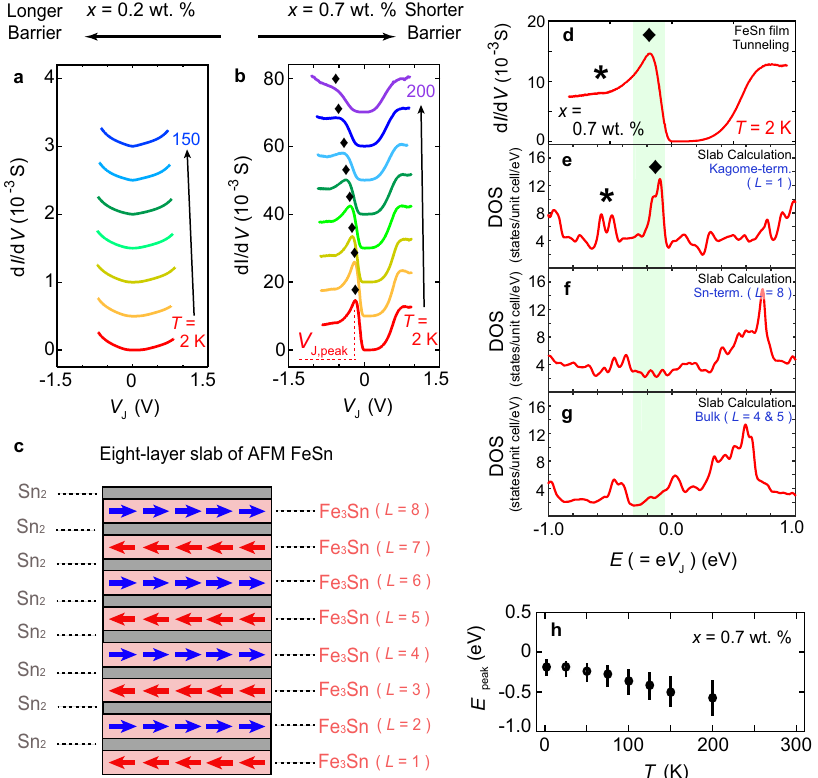
Fig. 3 Tunneling in x = 0.2, 0.7 wt.% junctions. d I /d V spectra at different temperatures for FeSn/Nb:STO junctions with a x = 0.2 wt.% and b x = 0.7 wt.%. The measurements were taken at T = 2, 25, 50, 75, 100, 125, 150, 200 K. Each curve is offset vertically by an equal amount with respect to the T = 2 K trace for clarity. For the x = 0.7 wt.% junction in b , the positions of the peak in d I /d V are marked with diamonds. c Schematic of the eight-layer slab of antiferromagnetic FeSn. d d I /d V spectrum for the x = 0.7 wt.% junction at T = 2 K. Energy-dependent DOS spectra at e the kagome-terminated surface, f the Sn-terminated surface, and g the bulk of the eight-layer FeSn slab with the antiferromagnetic spin con fi guration. The green-shaded box across d – g denotes the energy window in which the peak feature in d I /d V was observed. Diamonds and asterisks mark the positions of noticeable features that correlate between d and e . h Temperature-dependent d I /d V peak positions ( E peak ) (circles) and corresponding full widths at half maximum (FWHM) (vertical bar), extracted from b